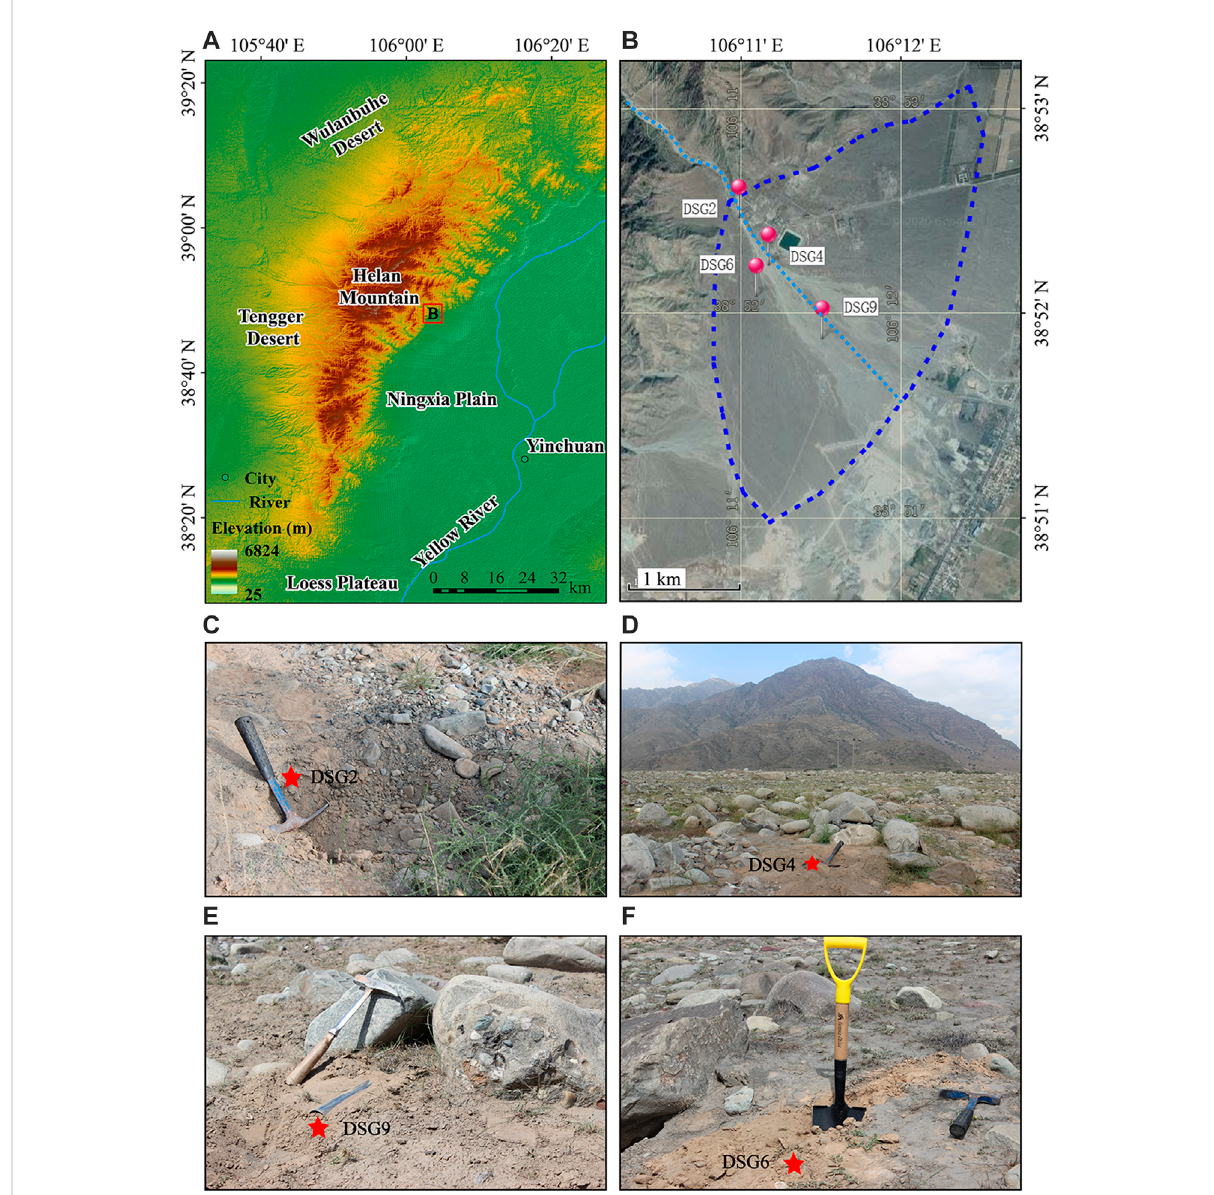
FIGURE 1 Location map of the study site. (A) Topographic map of Helan Mountain. (B) Satellite map of alluvial fan (sampling points are highlighted in red). (C – F) Photos showing the landscape and the sections from which samples were collected: three alluvial deposit samples (DSG2, DSG4, and DSG9) and one loess-like deposit sample